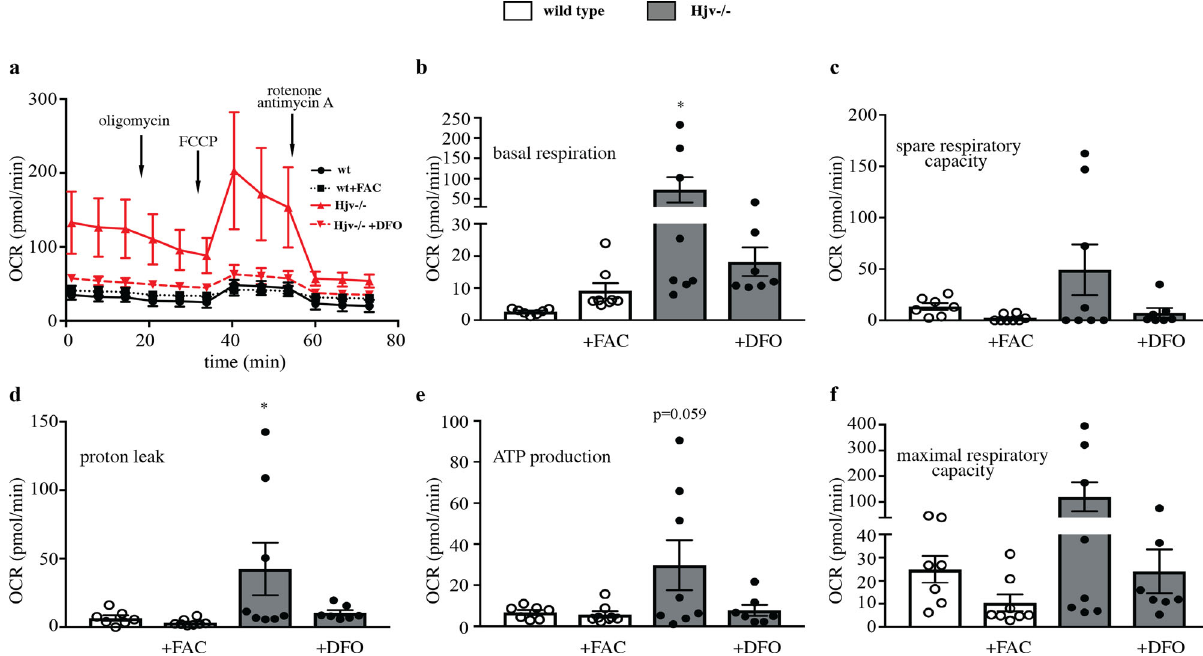
Fig. 9 Hjv de fi ciency causes iron-dependent mitochondrial hyperactivity in hepatocytes. Primary hepatocytes were isolated from wild type and Hjv − / − mice and left untreated or treated overnight with 15 μ g/ml ferric ammonium citrate (FAC) or 100 μ M desferrioxamine (DFO), respectively ( n = 7 – 8 technical replicates for each condition). Subsequently, the cells were analyzed for oxygen consumption rate (OCR) using the Seahorse assay. a OCR